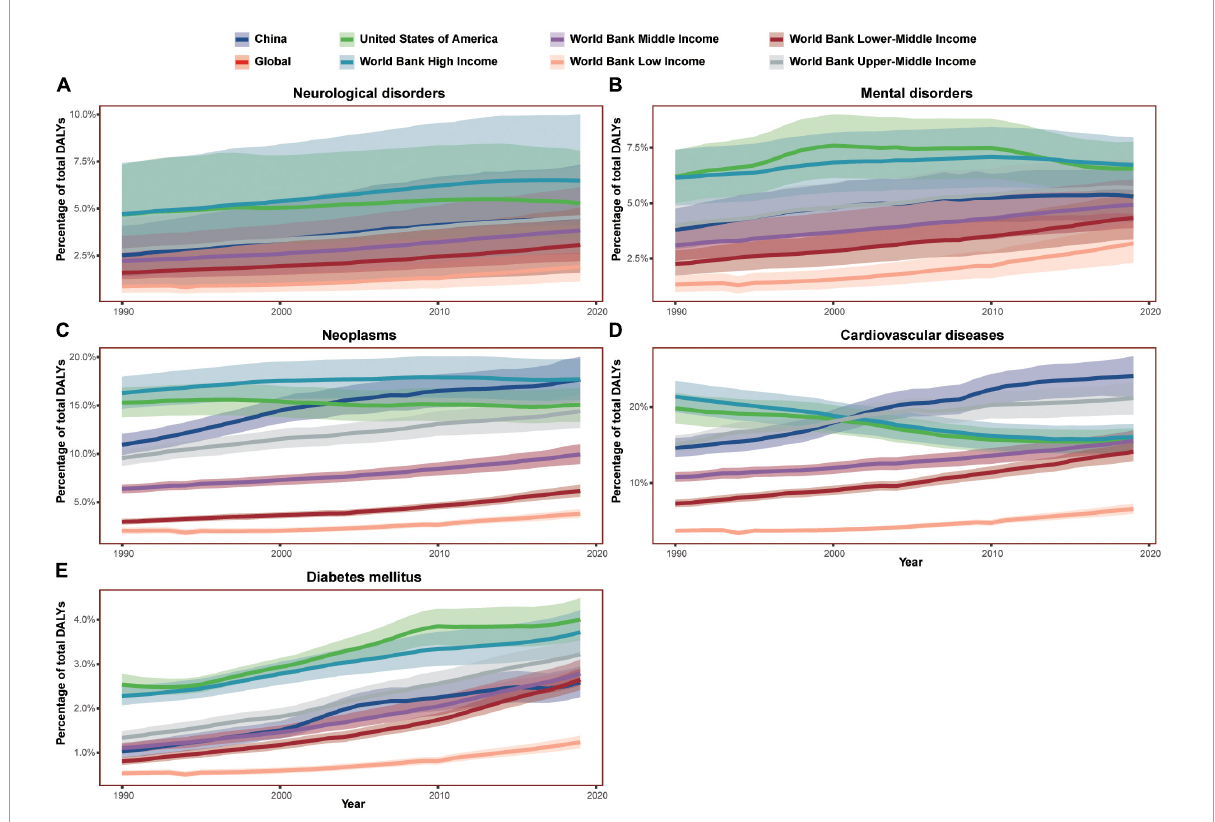
FIGURE1 The burden trend of all-ages neurological disorders, mental disorders, and three major physiological diseases in China, the United States of America, the world, and different income countries from 1990 to 2019. (A–E) Showed the DALY percent of neurological disorders, mental disorders, neoplasms, cardiovascular diseases, and diabetes mellitus, respectively. The graphs of World Bank middle income overlapped with that of the world. Shaded sections indicate 95% uncertainty intervals. DALYs, disability-adjusted